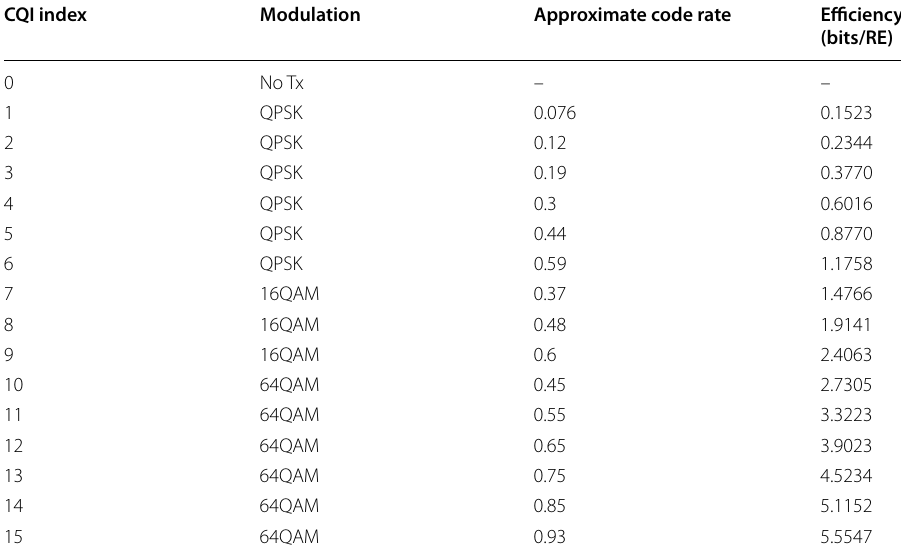
Table 1 CQI table by 3GPP